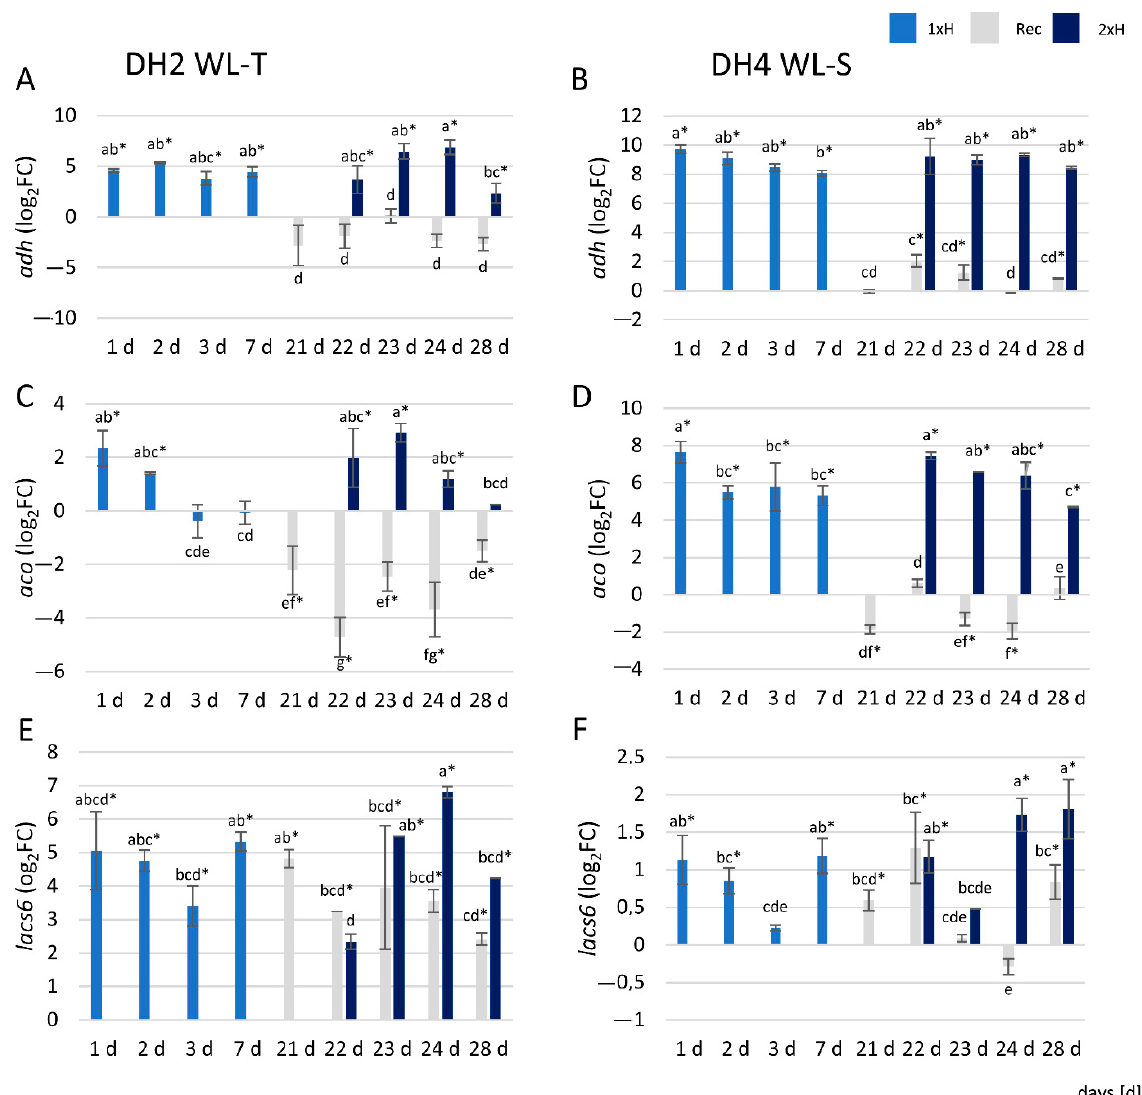
Figure 11. Expression profiles of the adh ( A , B ), aco ( C , D ), and lacs6 ( E , F ) genes in WL-T DH2 and WL-S DH4 cucumber accessions under waterlogging stress, respectively. Data are expressed as the mean ± SD (standard deviation) of three independent biological replicates and three technical replications with p < 0.05 (Tukey’s post-hoc test). Asterisks indicate a significant difference vs. control plants. The same letters indicate no statistical differences between treatments and time-points (days).